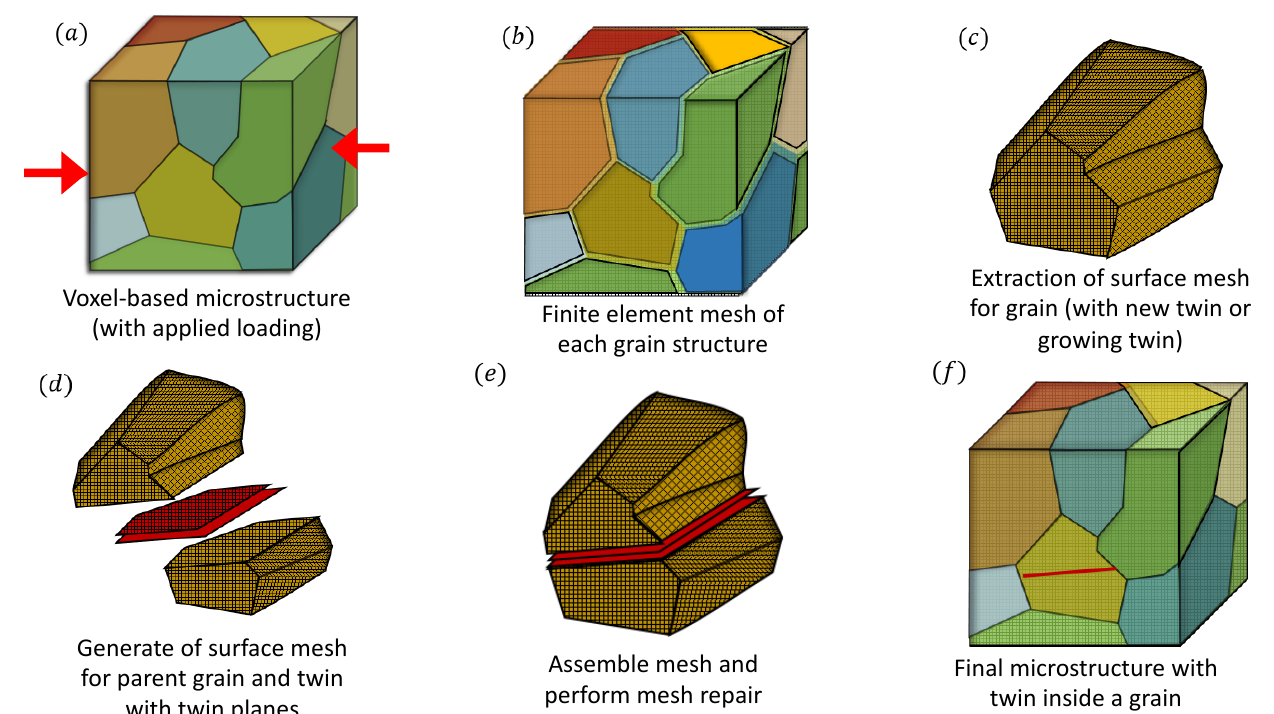
Figure 12. A schematic of the explicit incorporation of twinning. Voxel bases microstructure in ( a ) is meshed for each grain structure ( b , c ). ( d – f ) show final microstructure after explicit twin incorporation inside of the